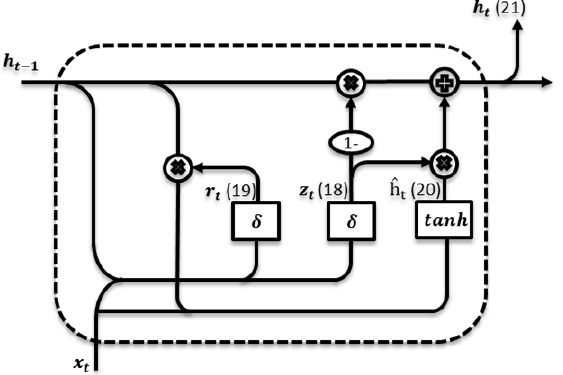
Figure 2. The architecture of the GRU cell. Numbered values correspond to the equation numbers below.